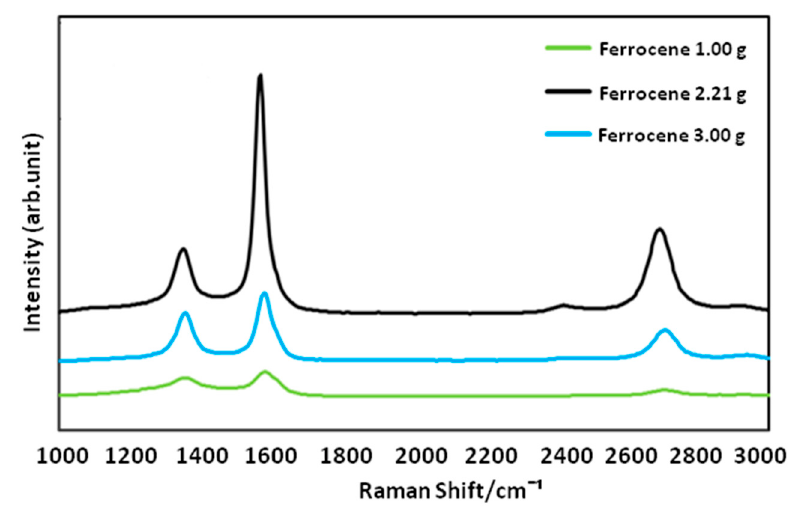
Figure 7. Raman spectra of CNFs prepared with different ferrocene concentrations.